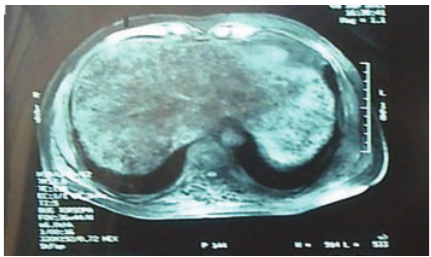
Figure 1: MRI depicting intrahepatic bile duct